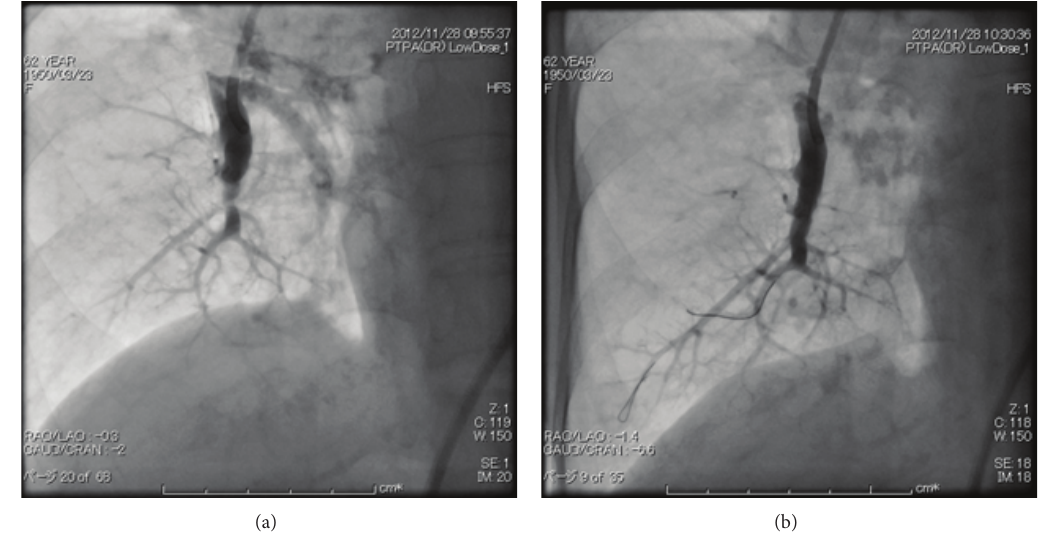
Figure 2: Initial percutaneous transluminal pulmonary angioplasty was performed for the right pulmonary artery (a). The A8 region of her right pulmonary artery was dilated by the balloon (plain old balloon atherectomy, b).